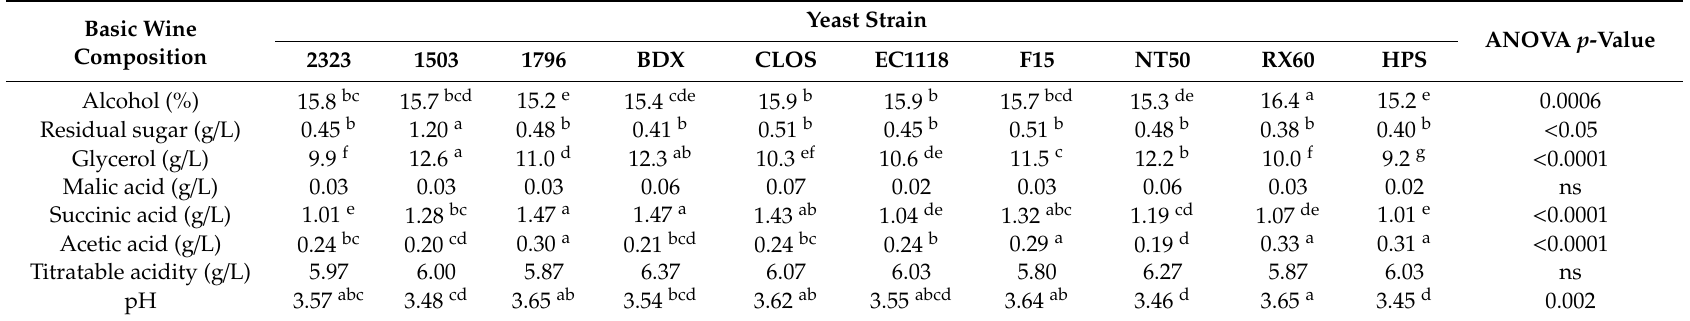
Table 2. E ff ect of yeast strain on basic wine compositional parameters (data show means compared by one-way ANOVA, where significant di ff erences of p < 0.05 were compared by a post-hoc Student’s t -test, with significant di ff erences within a row shown by di ff erent letters, ns = not